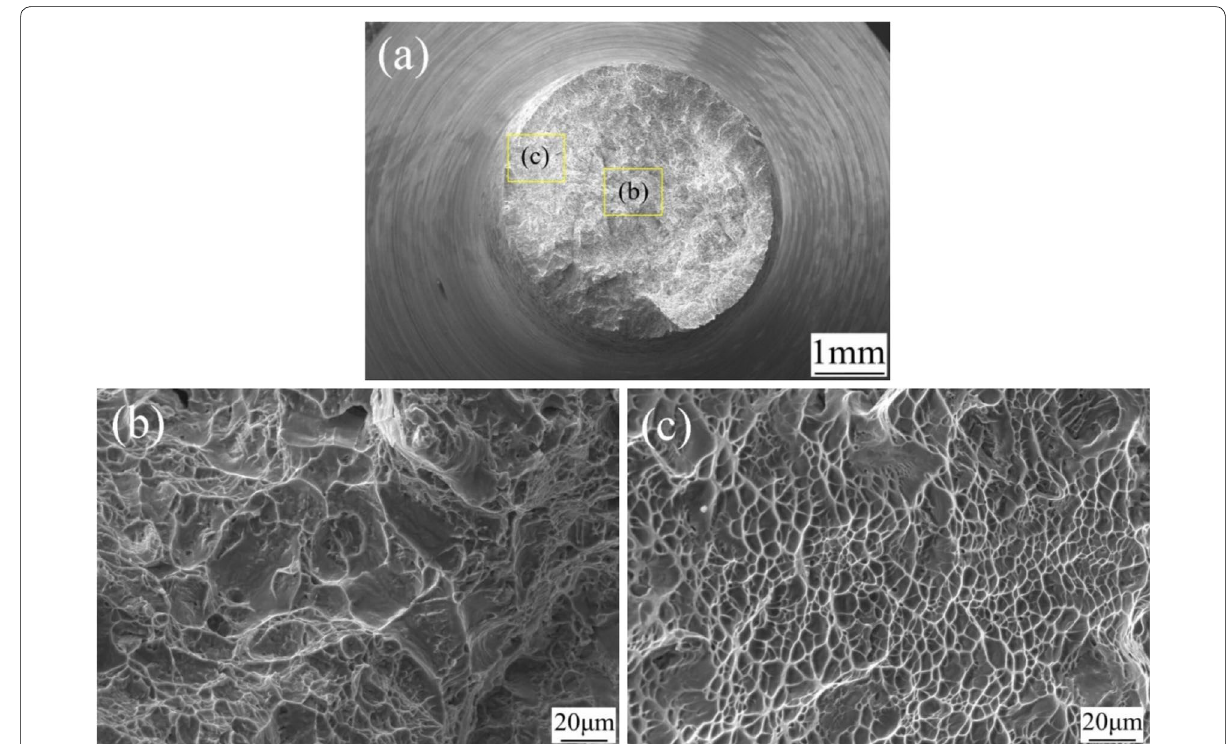
Figure 16 Fracture morphology of the tensile specimen at room temperature test: a Over view, b Center zone of fracture and c Edge zone of